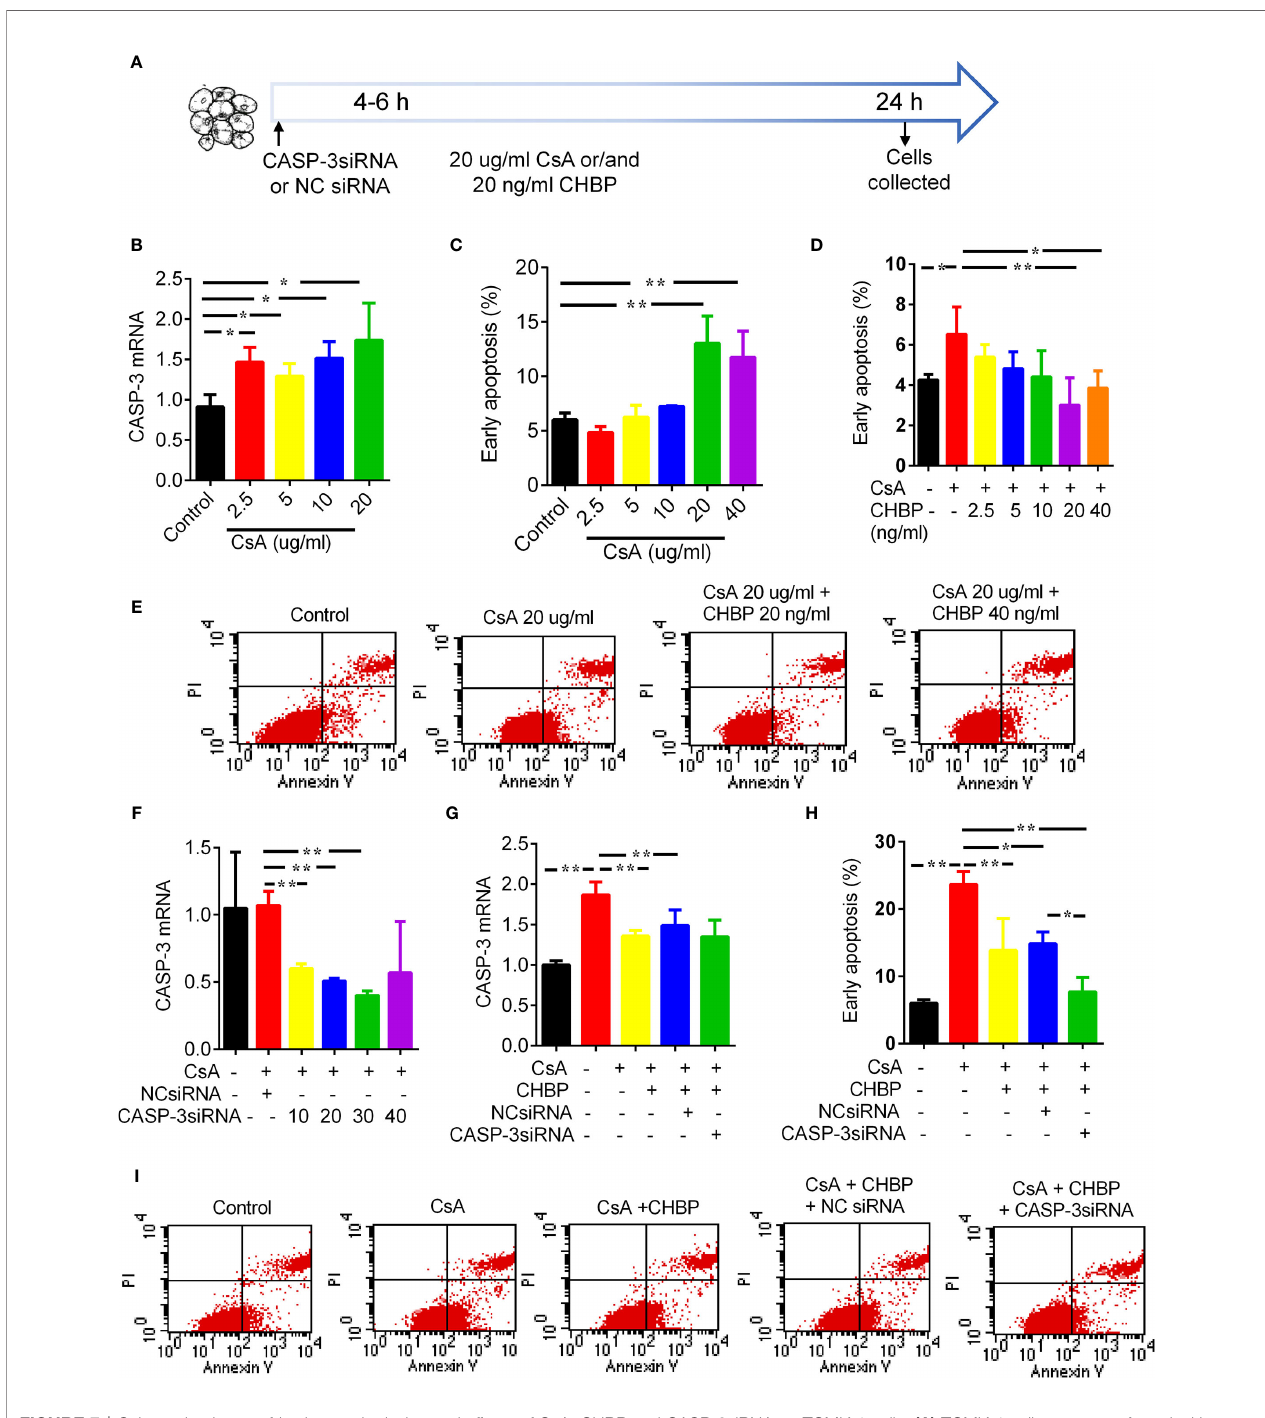
FIGURE 7 | Schematic picture of in vitro study design and effects of CsA, CHBP and CASP-3siRNA on TCMK-1 cells. (A) TCMK-1 cells were transfected with CASP-3siRNA 4 – 6 h before treated by CsA with/without CHBP for 24 h. (B) The level of CASP-3 mRNA was gradually increased by 2.5 – 20 m g/ml CsA. (C) The percentage of early apoptotic cells was signi fi cantly increased by CsA by 20 – 40 m g/ml and peaked at 20 m g/ml. (D, E) Early apoptotic cells was gradually reduced by 2.5 – 40 ng/ml CHBP, and reached statistical signi fi cance at 20 – 40 ng/ml. (F) The expression of CASP-3 mRNA was reduced by 10 – 30 nM/ml CASP-3siRNA compared with the control treated by 20 m g/ml CsA or with NCsiRNA, but the suppression was maximized at 30 nM/ml with 64.85% reduction. (G) CASP-3 mRNA were signi fi cantly increased by 20 m g/ml CsA, but reversed by 20 ng/ml CHBP with/without 30 nM CASP-3siRNA. (H, I) Early apoptotic cells was signi fi cantly increased by 20 m g/ml CsA, but reversed by CHBP with/without CASP-3siRNA or NCsiRNA. Data were expressed as the mean ± SD, (n = 3). * P < 0.05, ** P <